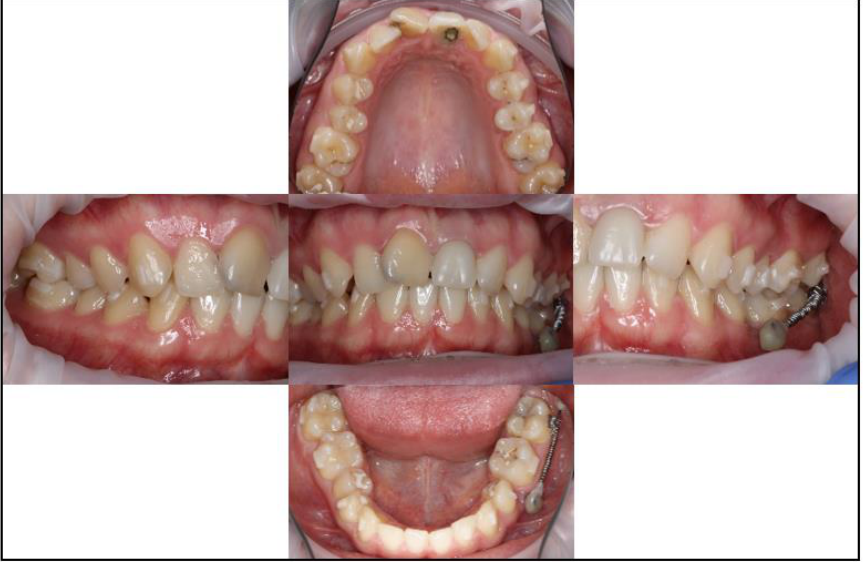
Figure 10. Intraoral pictures after four of aligners, and with a miniscrew for the distalization of tooth 37.